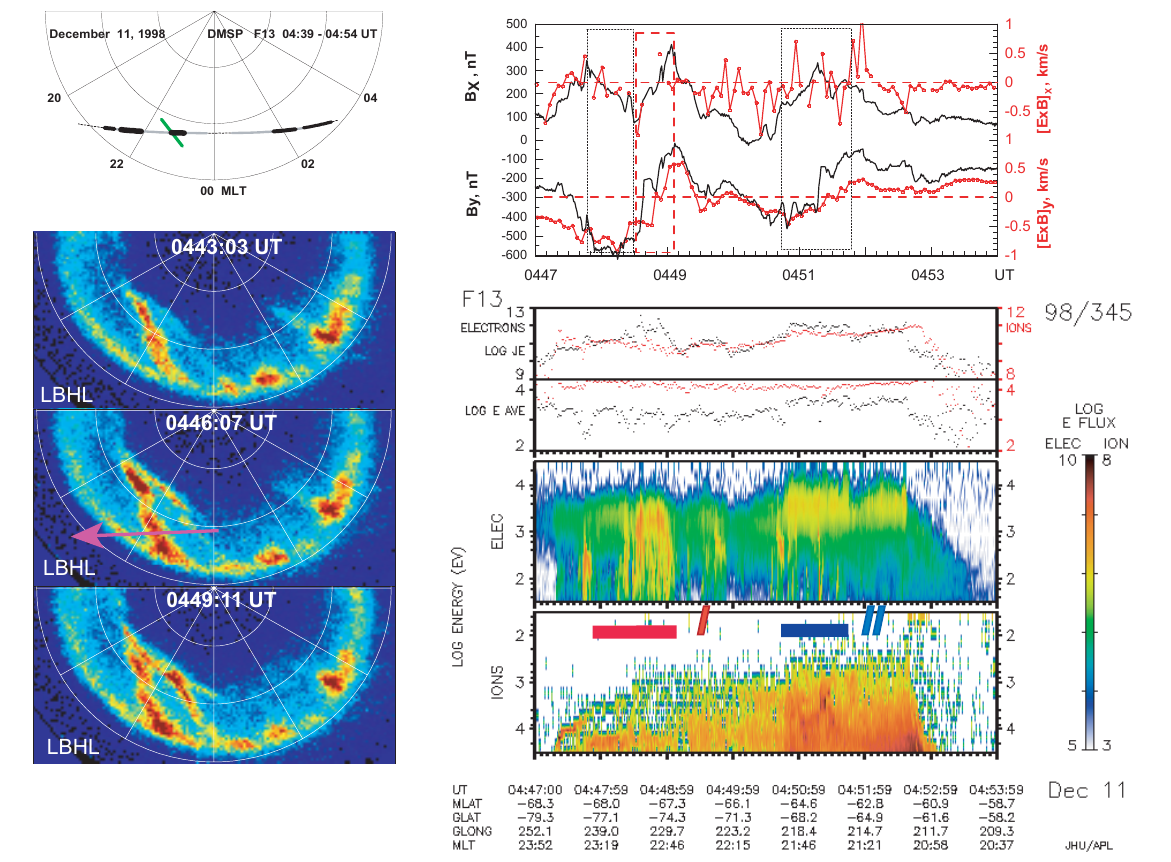
Fig. 3. Summary of observations during the streamer crossing by the DMSP F13 at 04:48 UT.